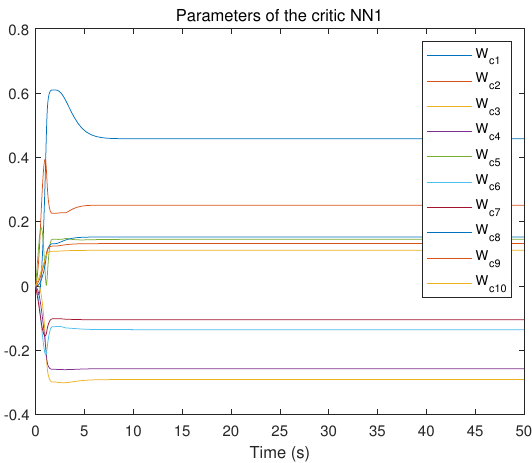
Figure 11. Convergence curves of critic NN1 weights for player